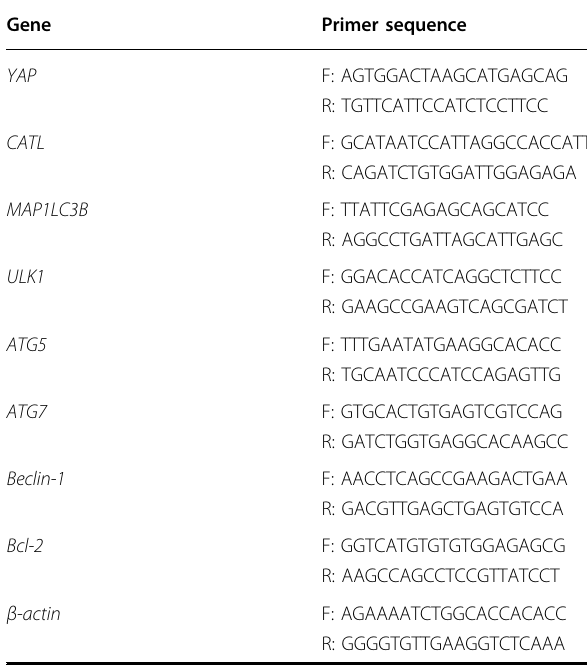
Table 1 Primers used for RT-qPCR